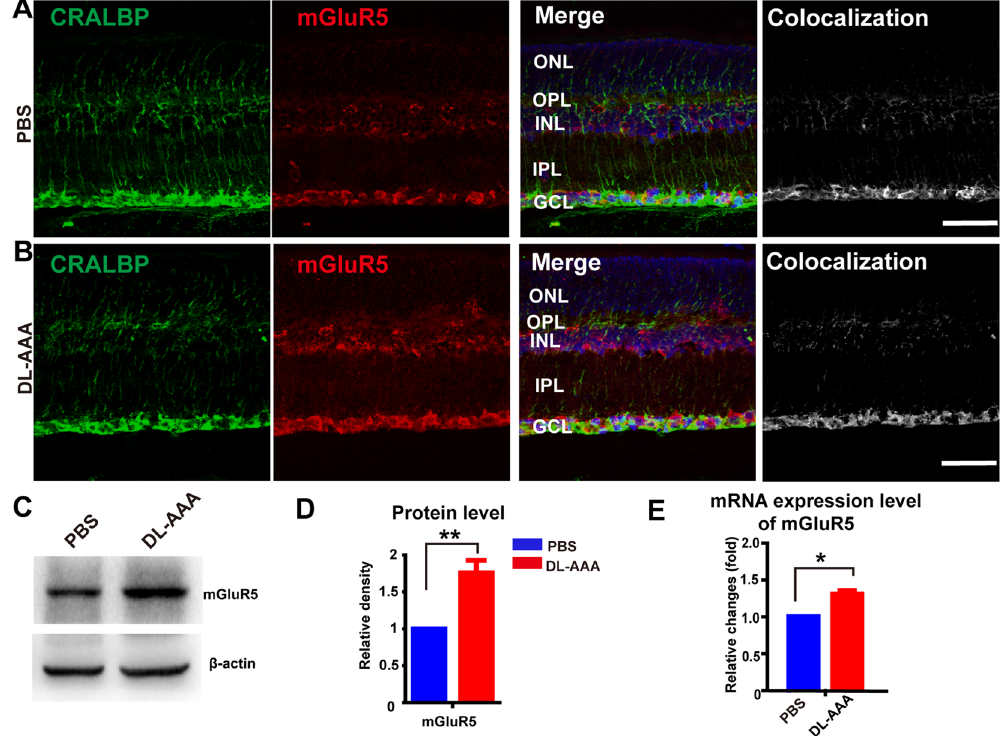
Figure 2. Subretinal DL-AAA injection caused increased expression of mGluR5. ( A ) Representative immunostaining for mGluR5 ( red ) and CRALBP ( green ) in a PBS-treated retina. Colocalization of the two ( right column ) is indicated by brightness of grey pixels. Scale bar = 50 µ m. ( B ) Same as A but for a DL-AAA treated retina. ( C ) Representative western blotting for mGluR5 expression 7 days following DL-AAA treatment. β -actin as loading control. ( D ) Quantification of mGluR5 protein expression by western blotting, 7 days following DL- AAA treatment (n = 3 per group). ( E ) mGluR5 mRNA expression 7 days after subretinal injection of either DL- AAA (or PBS control). Data are shown as mean ± SEM. * p < 0.05, ** p < 0.01. ONL, outer nuclear layer; OPL, outer plexiform layer; INL, inner nuclear layer; IPL, inner plexiform layer; GCL, ganglion cell